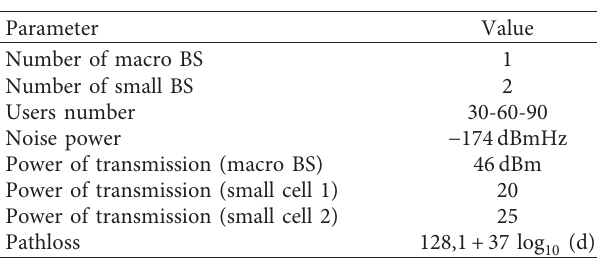
Table 6: Simulation